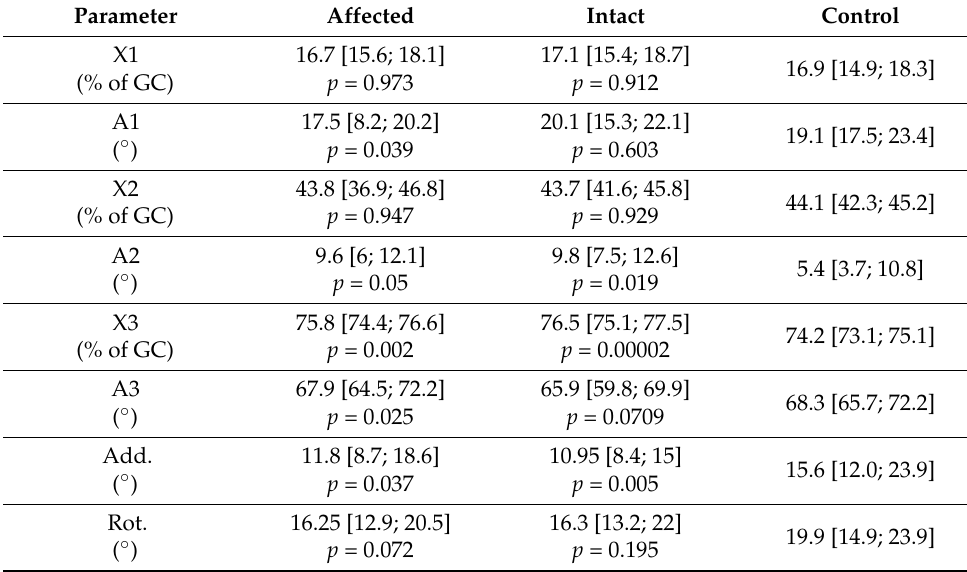
Table 4. Knee movement amplitudes and